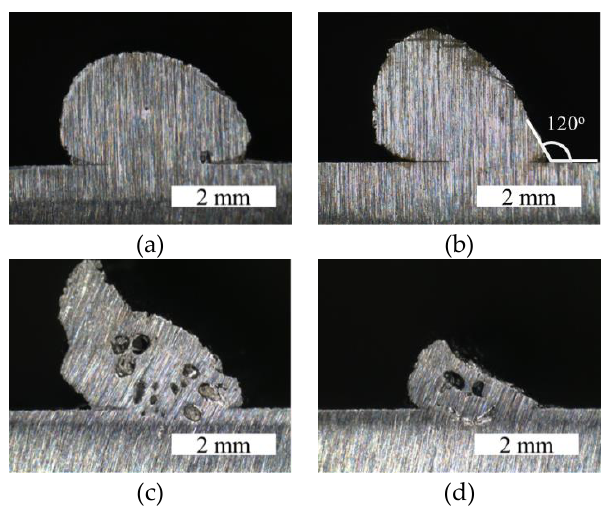
Figure 5. Cross-section of bead with various shift distance of beam ( a ) 0 mm, ( b ) 0.5 mm, ( c ) 1 mm, and ( d ) 2 mm.